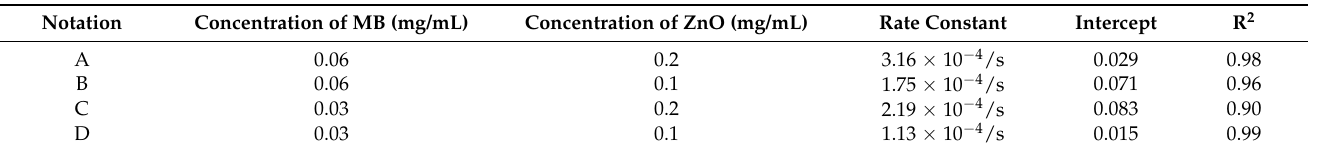
Table 2. Values of concentration of MB, ZnO, first order rate constants and correlation coefficients for the photocatalytic degradation of MB.